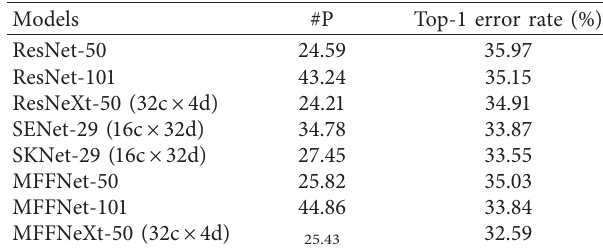
Table 2: Single 224 × 224 cropped top-1 error rate (%) and complexity comparisons on the Tiny ImageNet validation set. #P is the number of parameters. Atrous rate r � 1 , 2 , 3 { }